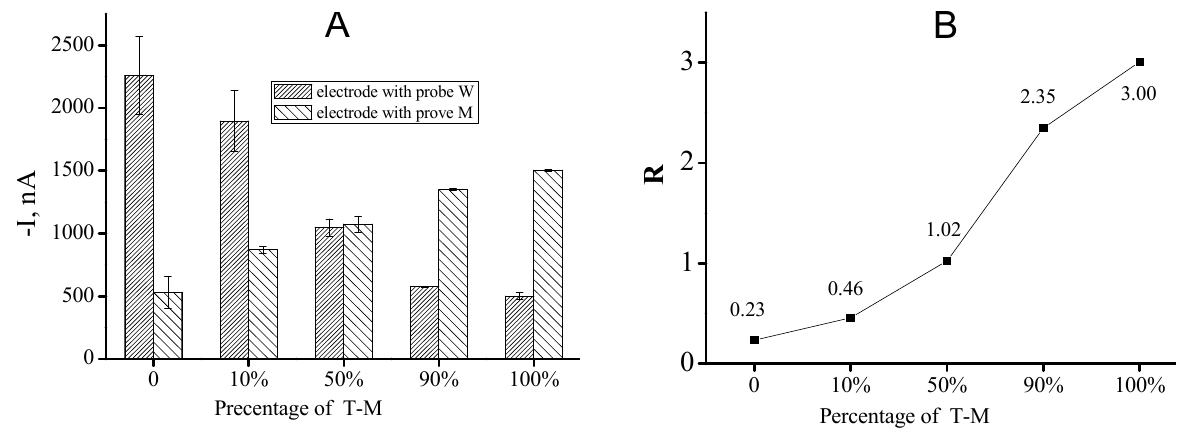
Figure 3. Results of a multiplexed SNP analysis on a 16-electrode array. The mixed sample consisted of T-M and T-W with a serious concentration ratio. (A) Comparison of current signals from two kinds of electrode when the concentration ratio was changed; (B) The signal difference ratio (R) got higher while the percentage of T-M was increased. The total concentration of target DNA was 5 nM.